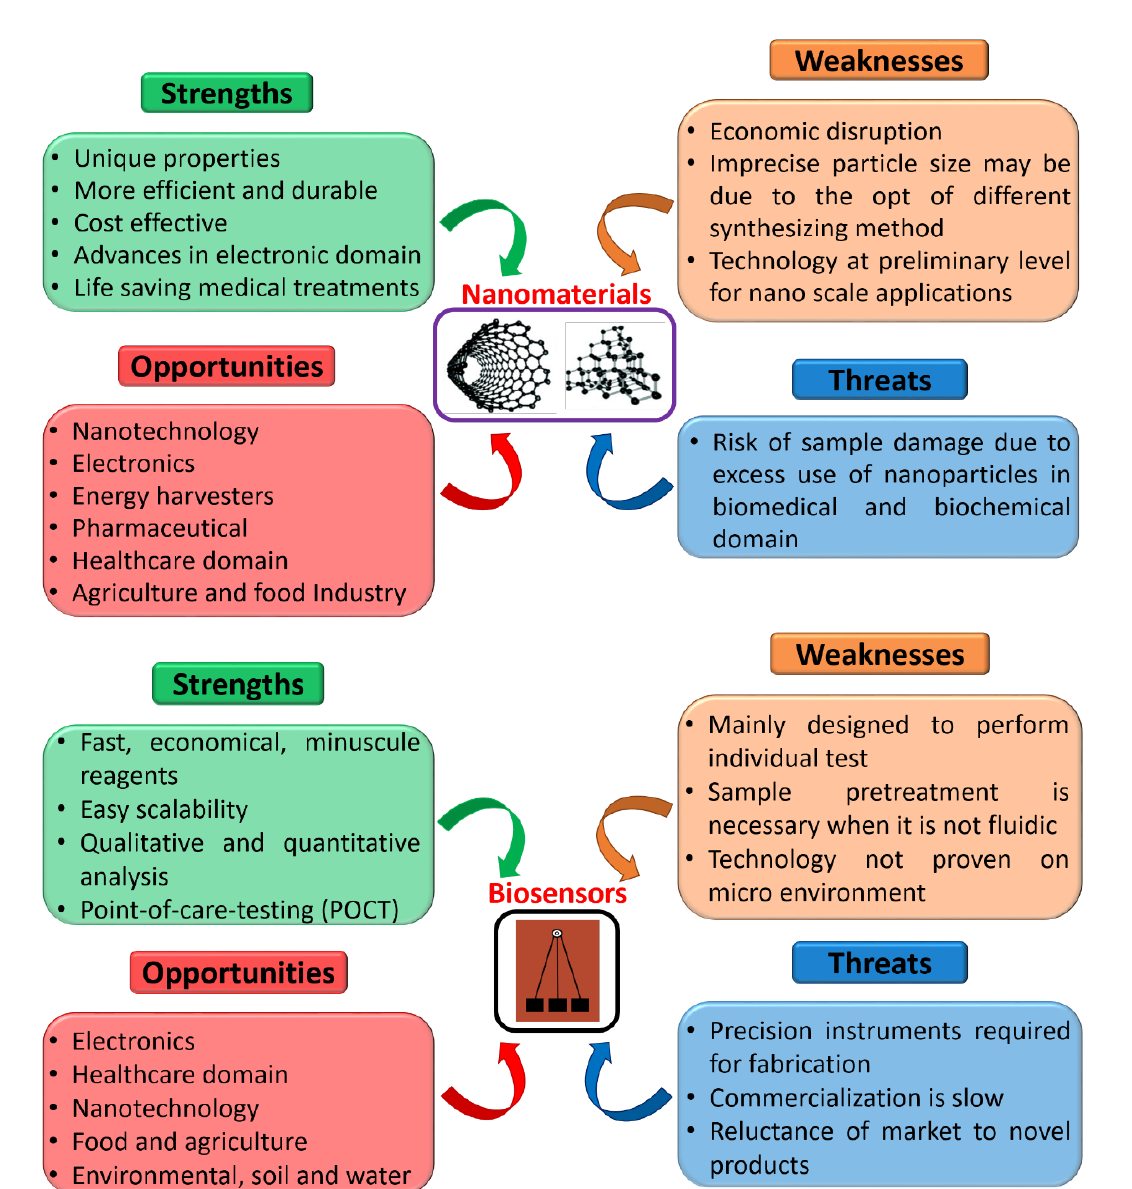
Figure 9. Detailed SWOT analysis of nanomaterials and biosensors.